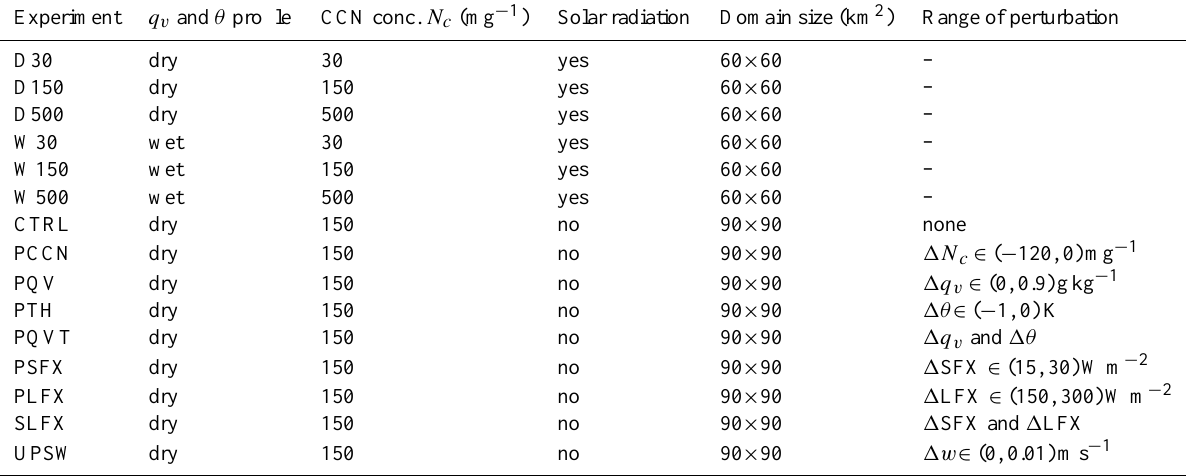
Table 1. Summary of numerical experiments; the first set is for diurnal cycles and the second set is for sensitivity study; “drier” (boundary layer q v =7.6gkg − 1 ; θ =289K) and “wetter” ( q v =8.5gkg − 1 ; θ =288K) soundings are depicted in Fig. 1; perturbations in the second set are applied to the center 30 × 30km 2 of the domain in a spatially random